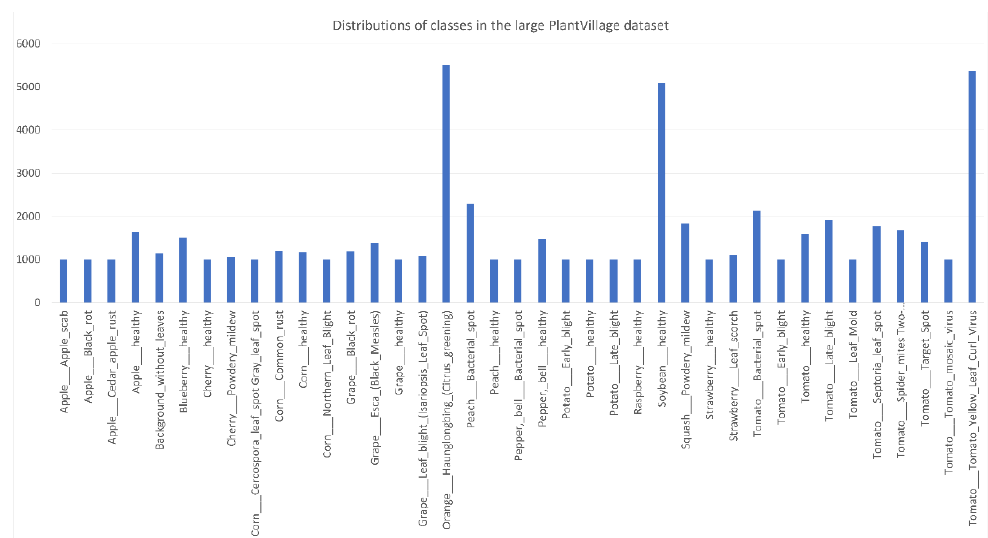
Figure 7. Distribution of classes in the large PlantVillage dataset.